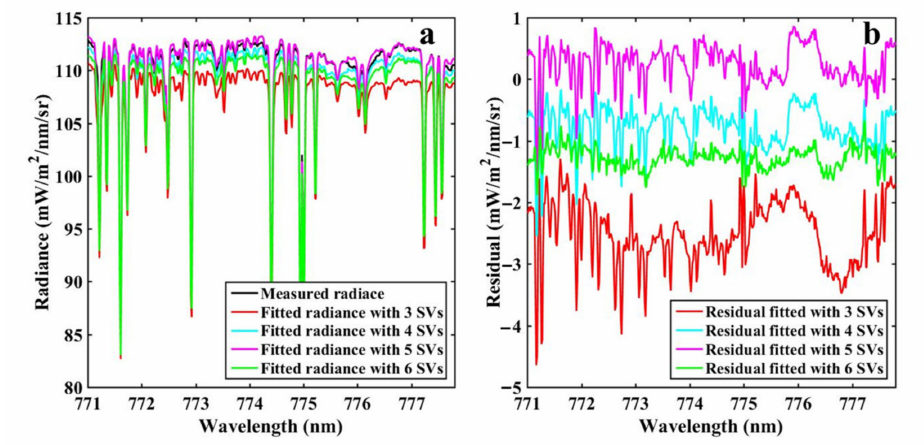
Figure 9. Spectral fits ( a ) and fit residuals ( b ) with different number of